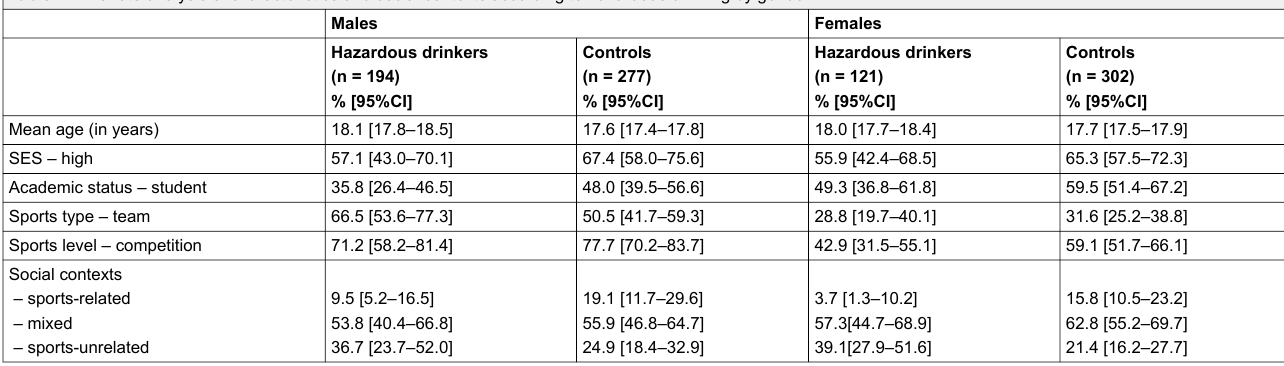
Table 1: Bivariate analysis of characteristics and social contexts according to hazardous drinking by gender. Males Females Hazardous drinkers (n =